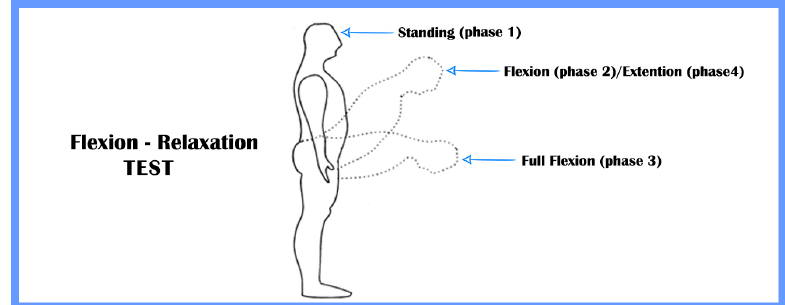
Figure 2. Representation of the movement performed by the subject during the flexion relaxation test.